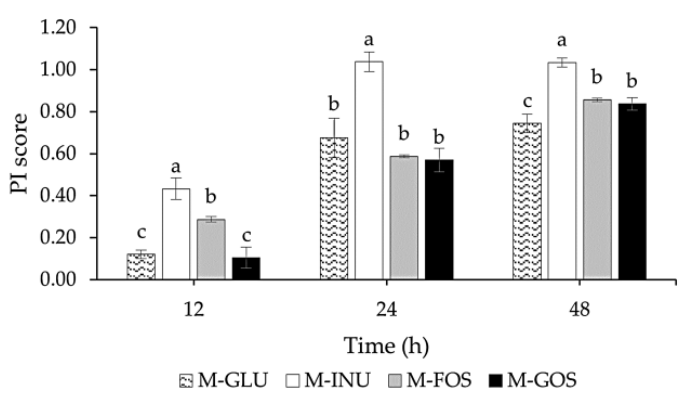
Figure 4. The PI score of co-culture bacterial strains in the different mediums supplemented with glucose (control) and prebiotics at 12, 24, and 48 h of incubation time, for which the various letters showed a significant mean difference ( p < 0.05) in each incubation time.